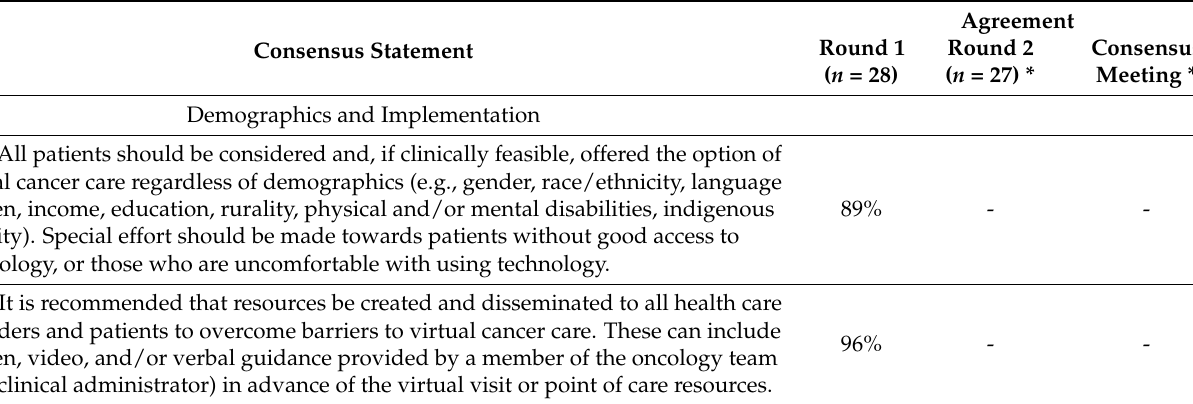
Table 1. Section A—Demographics, implementation, and